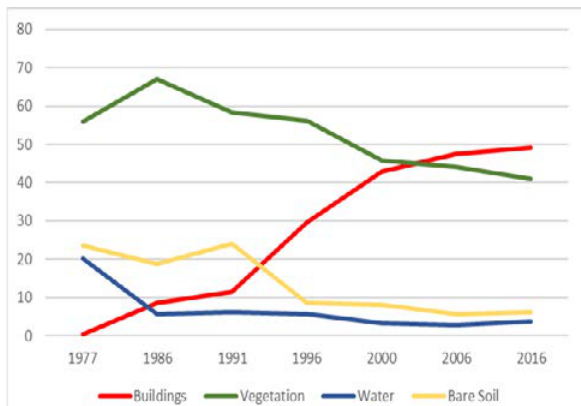
Figure 5: The increase in urban/building (built-up) area leading to the decrease in agricultural land